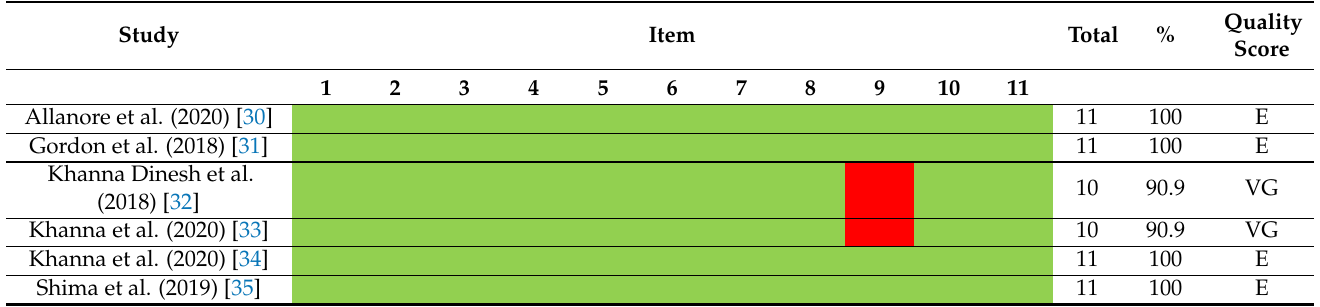
Table A2. Results of the methodological quality assessment of included studies—PEDro scale